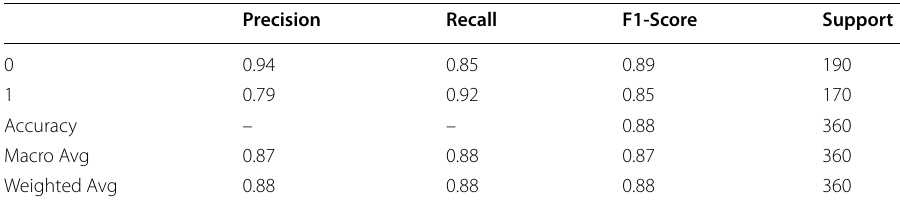
Table 7 Experiment 1 with AJGT